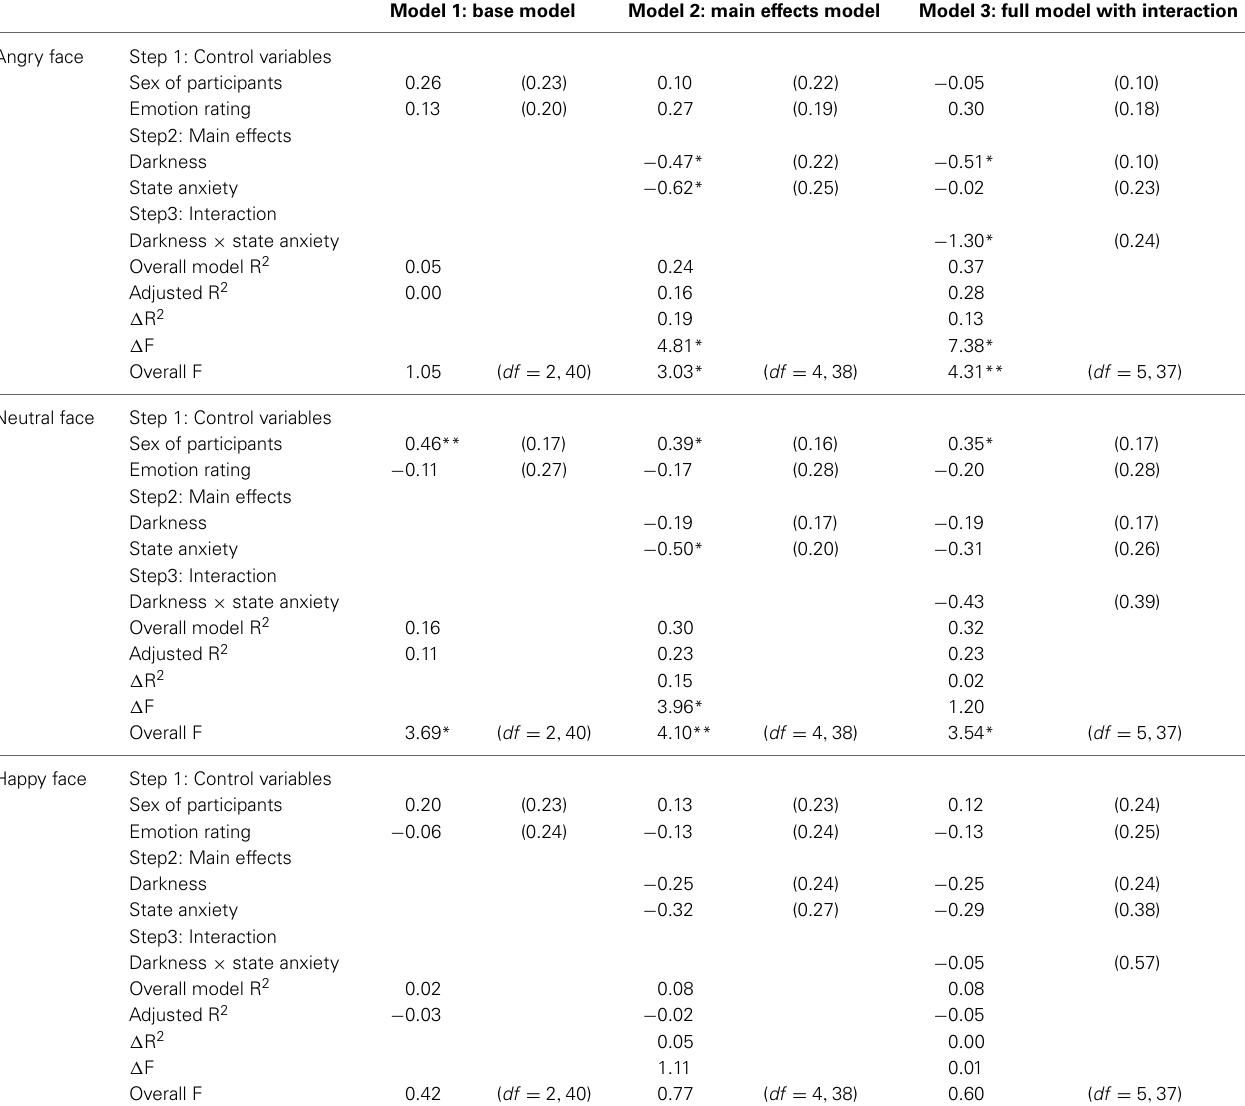
Table 2 | Results of hierarchical regression analyses predicting recognition performance (d (cid:2)